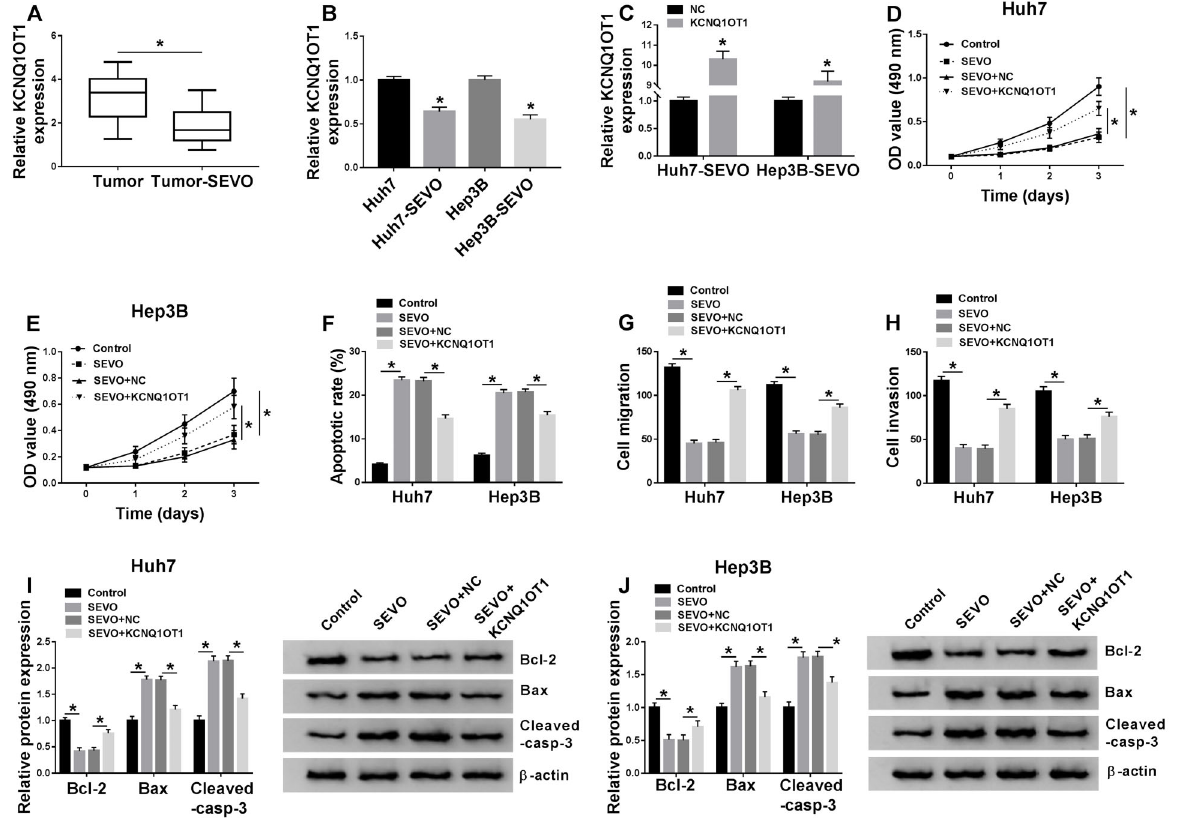
Figure 2. KCNQ1OT1 overexpression reversed the effects of sevo fl urane (SEVO) on hepatocellular carcinoma (HCC) progression. Huh7 and Hep3B cells were transfected with KCNQ1OT1 or negative control (NC) and then stimulated with 4% SEVO for 48 h. A , KCNQ1OT1 expression was detected by qRT-PCR assay in HCC tumor tissues (n=30) and SEVO-treated HCC tumor tissues (n=30). Data are reported as median and interquartile range. *P o 0.05 (Kruskal-Wallis). B and C , KCNQ1OT1 expression was detected by qRT-PCR assay (n=3). D and E , Cell proliferation ability was measured by MTT assay (n=3). F , Cell apoptosis rate was examined by fl ow cytometry (n=3). G and H , Transwell assay was employed to investigate cell migration and invasion (n=3). I and J , Western blot assay was carried out to measure the levels of cell apoptosis-related proteins (Bcl-2, Bax, and Cleaved-casp-3) (n=3). Data are reported as means ± SD. *P o 0.05 (Student ’ s t -test or